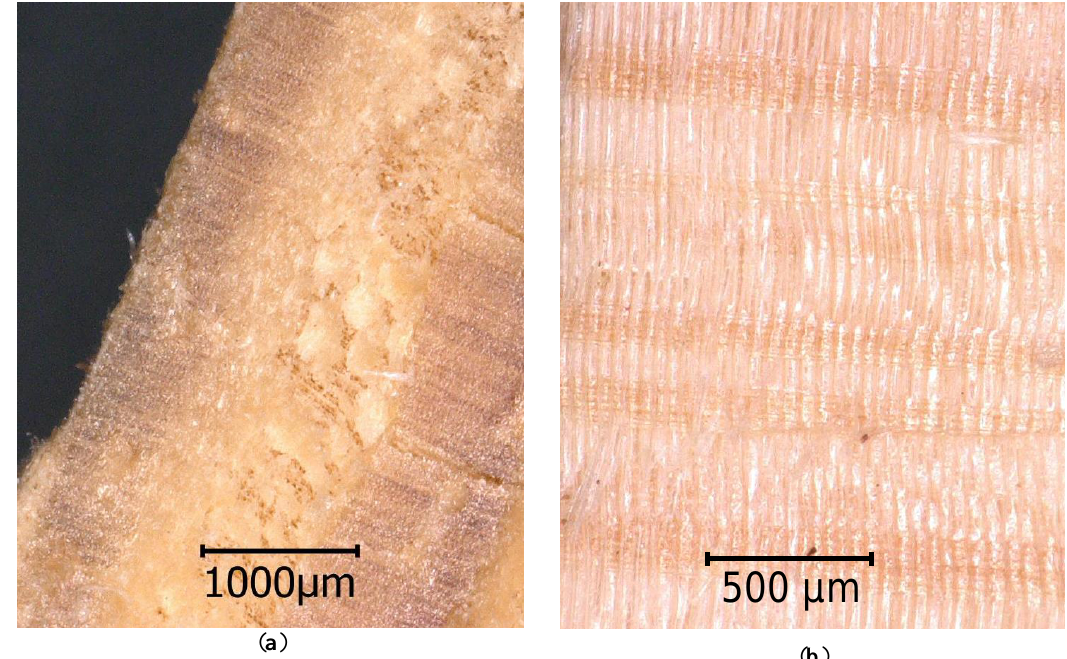
Figure 2. The fracture pattern in the softwoods: ( a ) Cross section of the Scots pine heartwood, fracture along a growth ring border; ( b ) The radial fracture section of the Douglas fir heartwood, fracture along the rays.